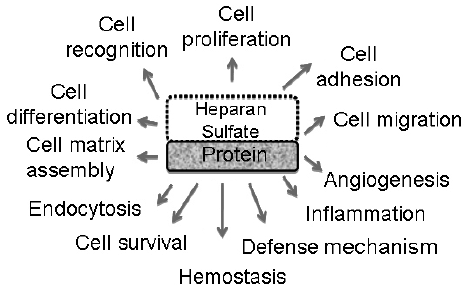
Fig. 2 – Biological activities modulated by the interaction of pro- teins with heparan